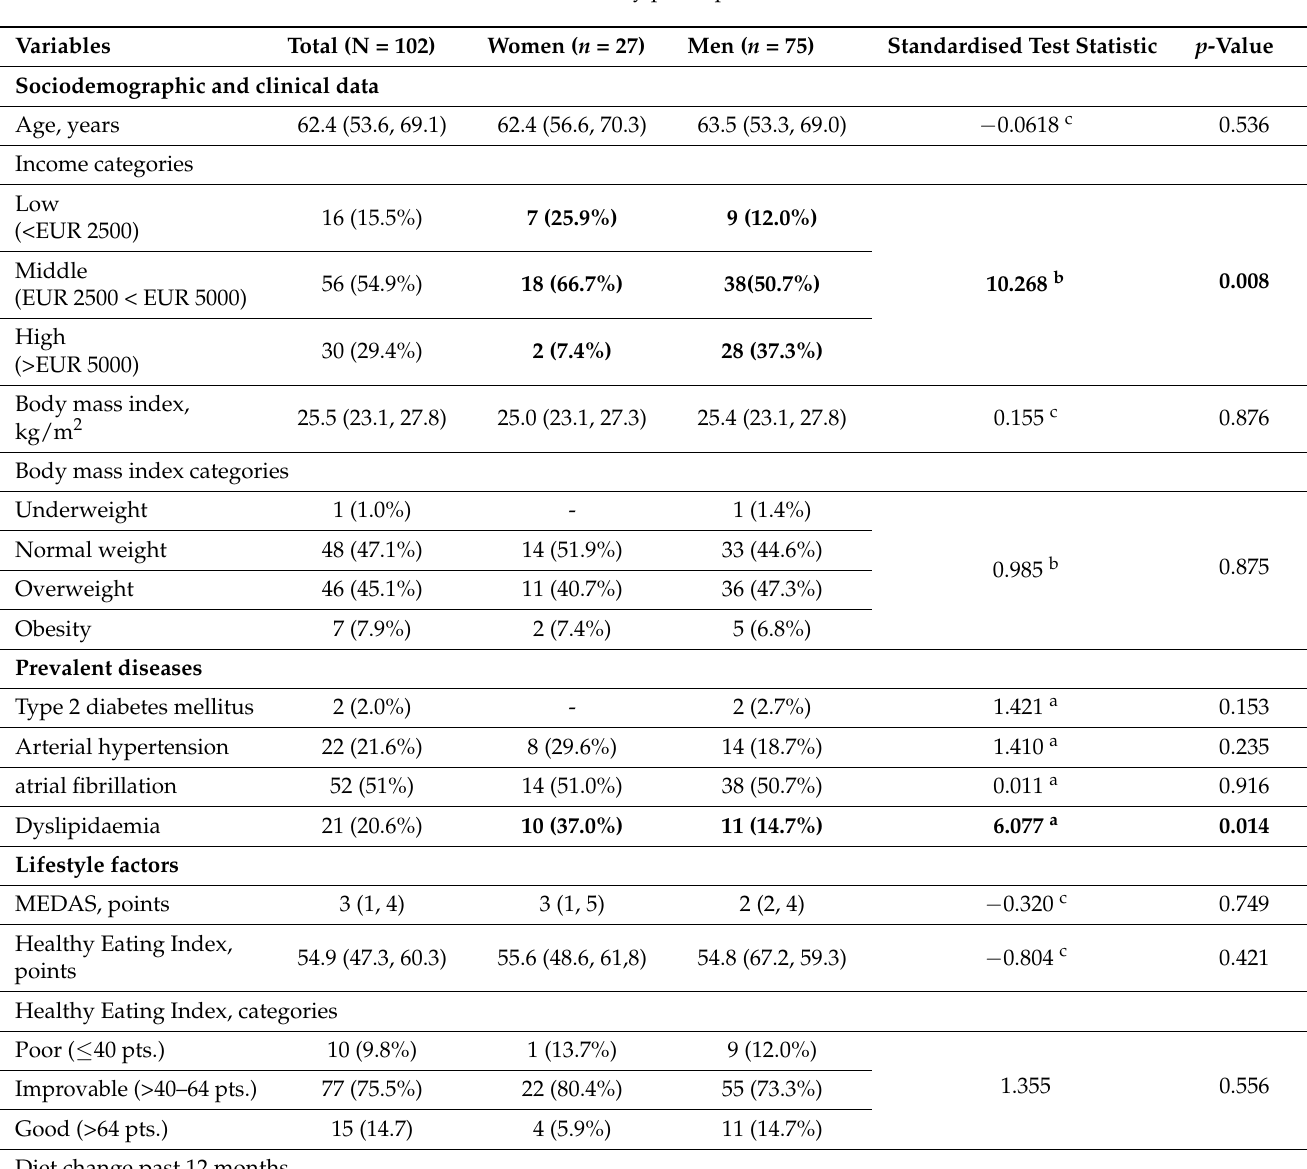
Table 1. Characteristics of study